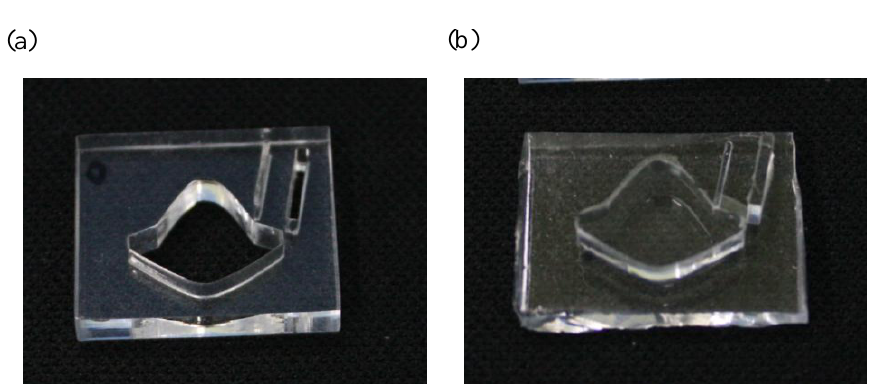
Figure 3. ( a ) PMMA mold and ( b ) PDMS hybrid